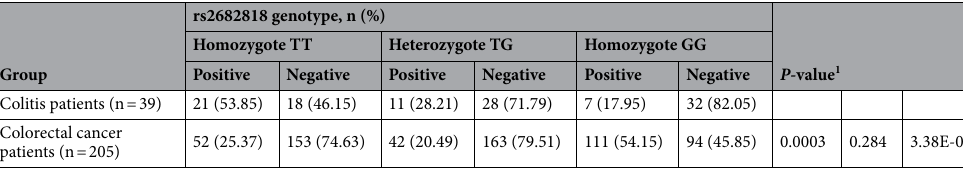
Table 1. Nucleotide variation characteristics of studied subjects. 1 Two-sided χ 2 test for the distributions of homozygote TT (1st column), heterozygote TG (2nd column) and homozygote GG (3rd column) between colorectal cancer patients and Colitis patients as